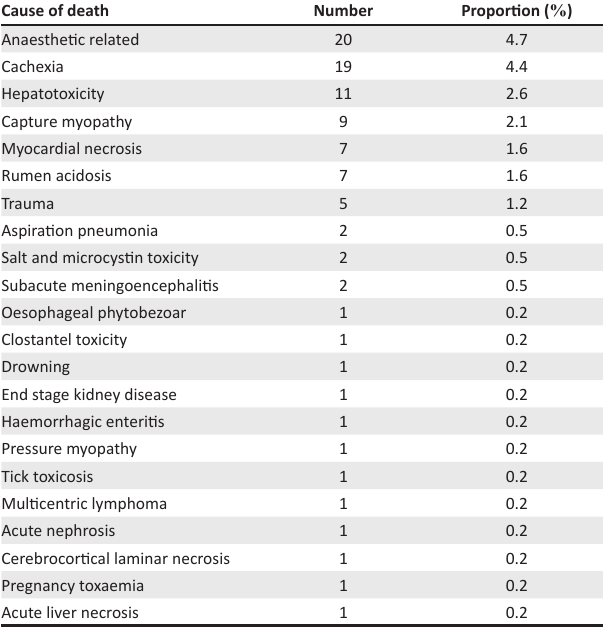
TABLE 4: Miscellaneous non-fatal lesions in African